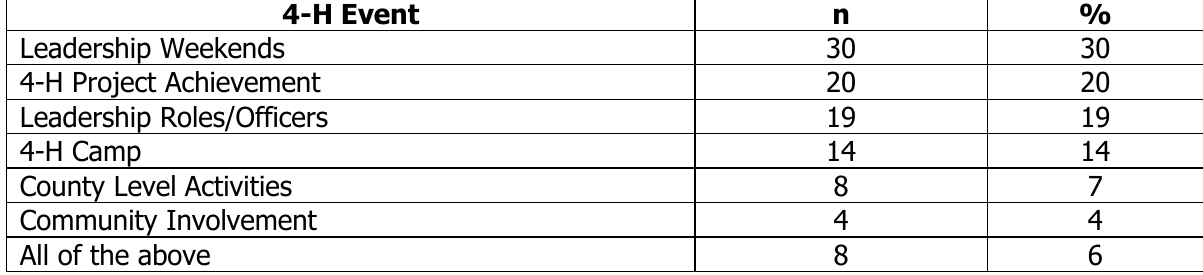
4-H Event that gives Confidence to Ignore the Bullying Situation